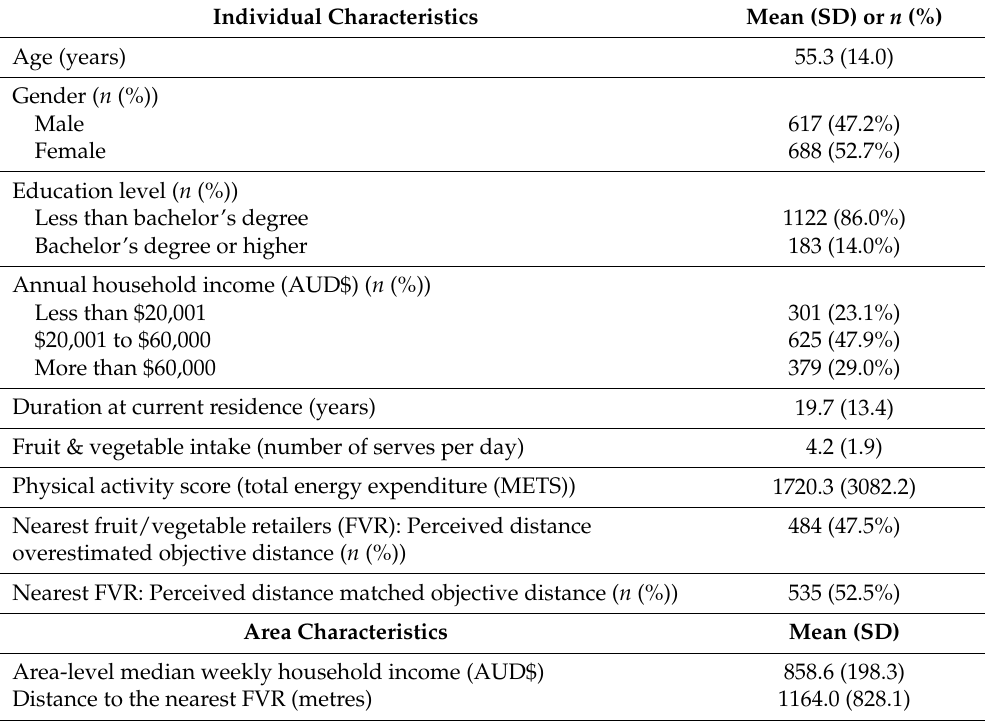
Table 1. Individual and area characteristics of the sample ( n = 1305).